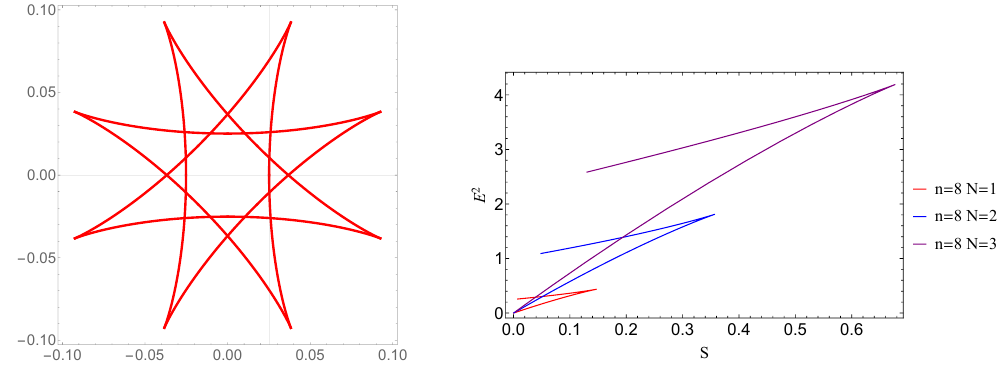
Figure 10 . The left panel shows the shape of spiky string with 8 outward spikes and 3 windings for ρ 0 . 025 and ρ = 0 . 1 . The right panel shows the Regge trajectories of different windings. 0 ’ 1 The spin S and the energy E are plotted in the units of R 2 /α 0 and R/α 0 , respectively. supported by de Sitter acceleration. Then, one may expect that such solutions collapse into folded strings when the string is small and so the support of de Sitter acceleration is not enough. Indeed, we find that the Regge trajectory of n = 2 N outward spikes branches from the turning point of the folded string